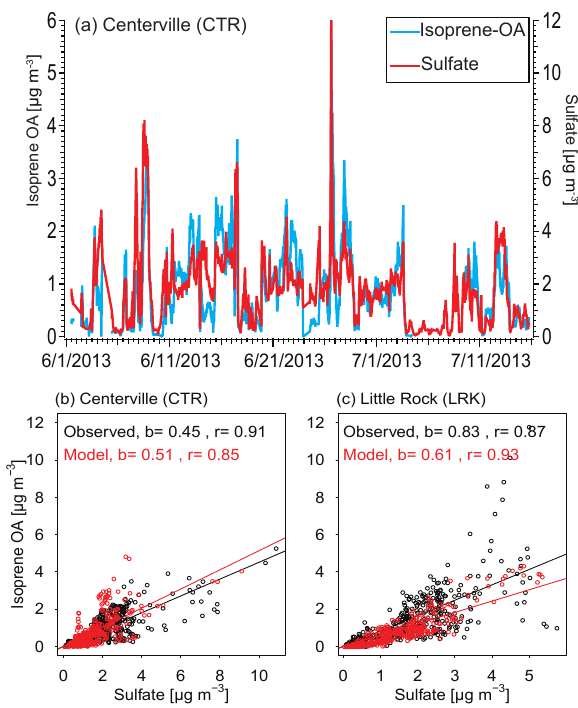
Figure 2. Time series and correlation between isoprene OA and sul- fate during SOAS (Pye et al., 2016; Xu et al., 2015). Panel (a) shows the time series of both isoprene OA and sulfate at the Centerville site during SOAS. Panel (b) and (c) shows the correlation plot between isoprene OA and sulfate from both measurements and model results at two sites (Centerville and Little Rock) during